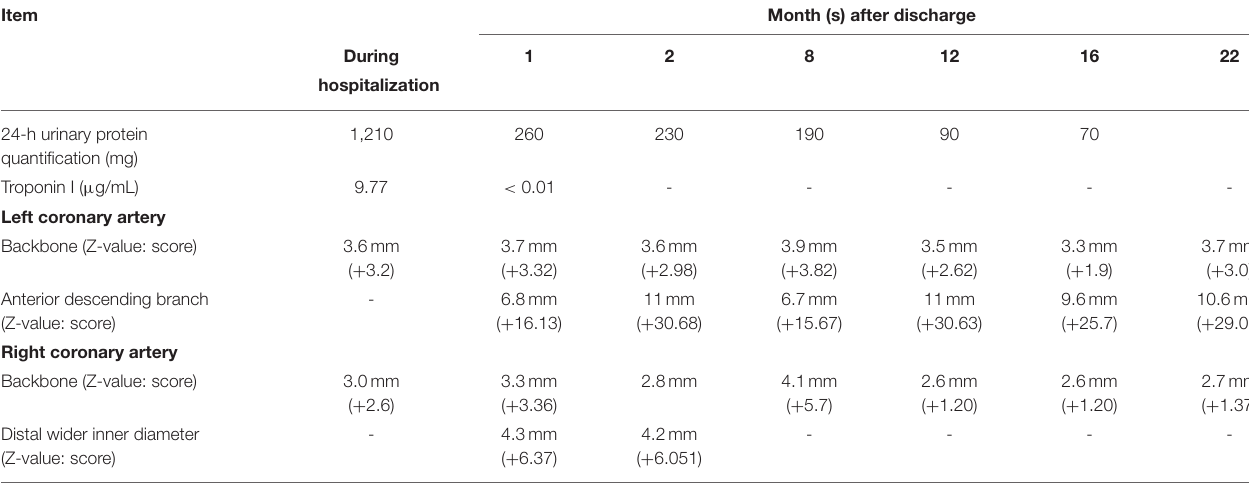
TABLE 2 | Follow-up of proteinuria, troponin I, and cardiac color Doppler ultrasound of the HSP/IgAV child after discharge.